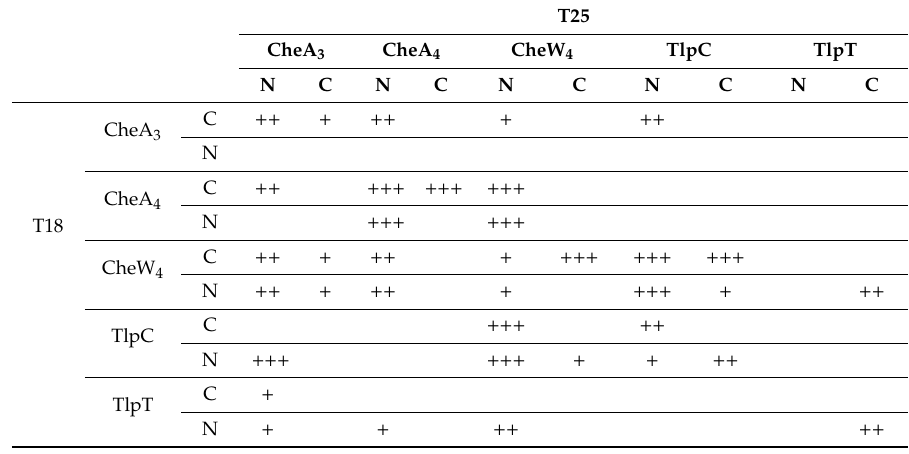
Table 1. Bacterial two-hybrid assay results showing interactions between cytoplasmic cluster proteins tagged on N and C terminals after 24 h incubation ( + ), between 24 and 72 h incubation ( ++ ), and after 72 h incubation ( +++ ). Empty squares indicate no interaction within 72